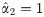
Feasible flux region with low cost respiration and unlimited substrate.α1 = 1, α2 = 1, α3 = 10, Γ = 200, α^2=1 and V1 = ∞ (entire shaded region). Lower case letters refer to constraints. Also shown are the level contours for the objective function ATP. The optimal solution is at point B in which (v2, v3) = (0, 18.18), corresponding to v1 = 18.18, ATP = 581.8 and a yield ratio of ATP/v1 = 32.